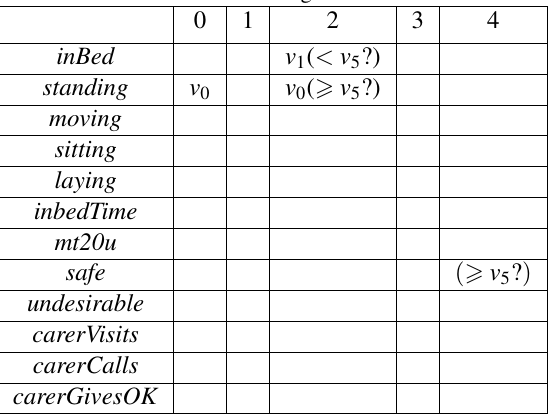
Table 5. The Searching Process of T1